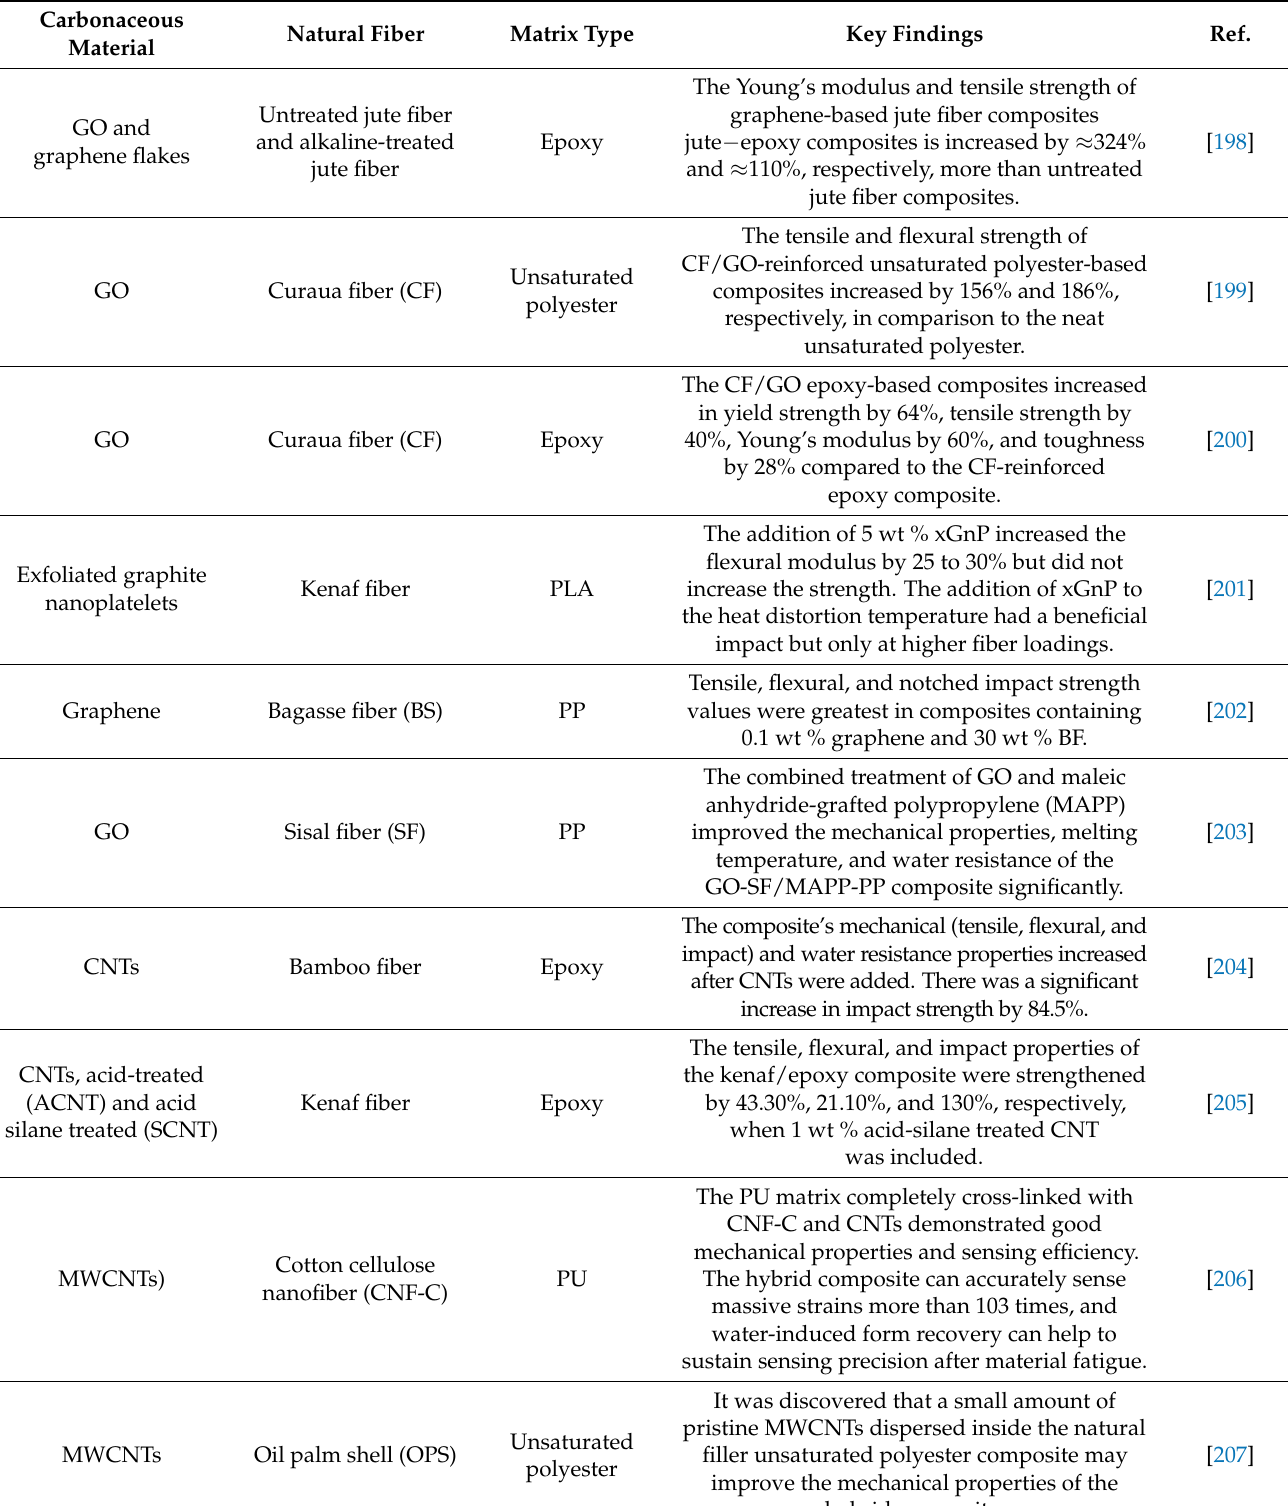
Table 7. Studies on hybrid natural fiber/carbonaceous material-reinforced polymer